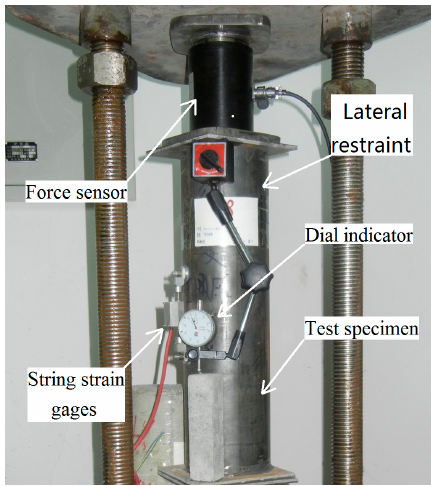
Figure 2. Example of a creep test on the specimen with lateral restraint. Materials 2019 , 12 , x FOR PEER REVIEW